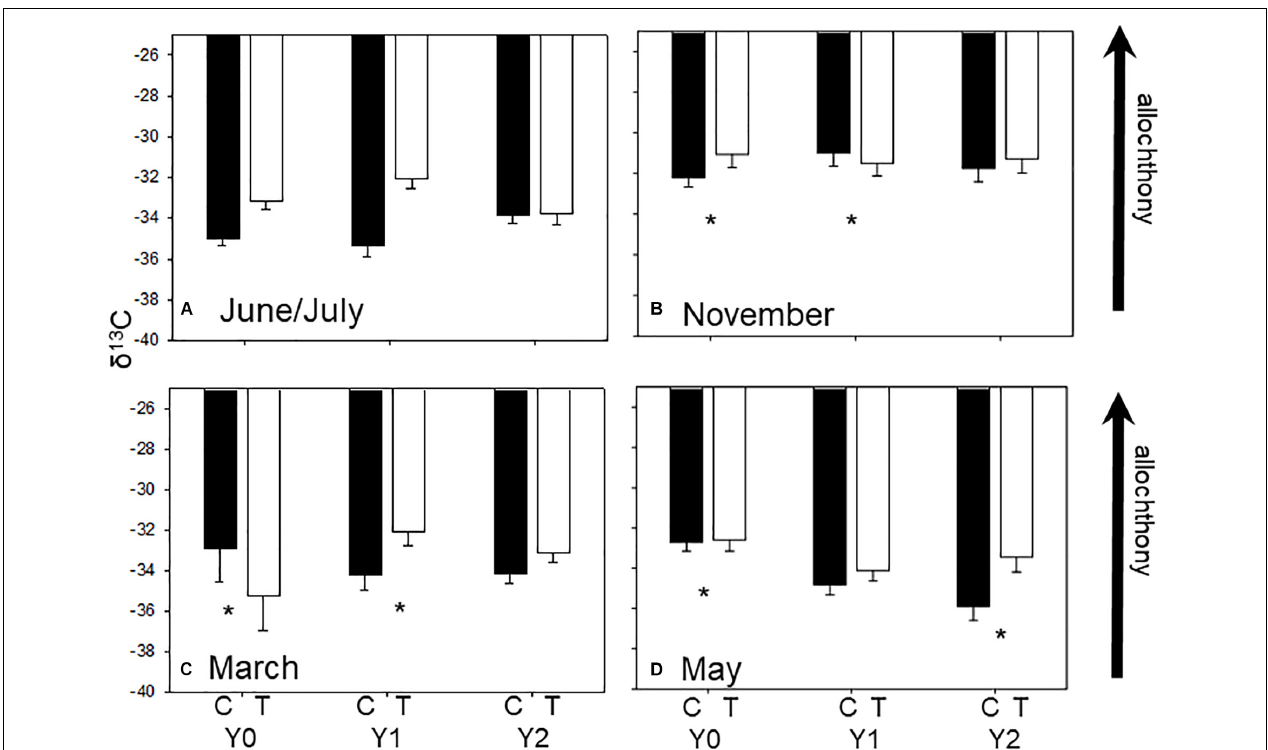
FIGURE 1 | Average ( ± SE) seasonal δ 13 C values in each stream reach 1 year before (Y0) and 1 (Y1) and 2 years (Y2) after wood addition in control (C, light bars) and treatment (T, dark bars) in State Creek (Michigan). Dashed lines are average leaf litter δ 13 C values. * Indicates a significant interaction between control and treatment reaches using ANOVA. (A) Are average seasonal δ 13 C values from June/July, (B) are average seasonal δ 13 C values from November, (C) are average seasonal δ 13 C values from March and (D) are average seasonal δ 13 C values from